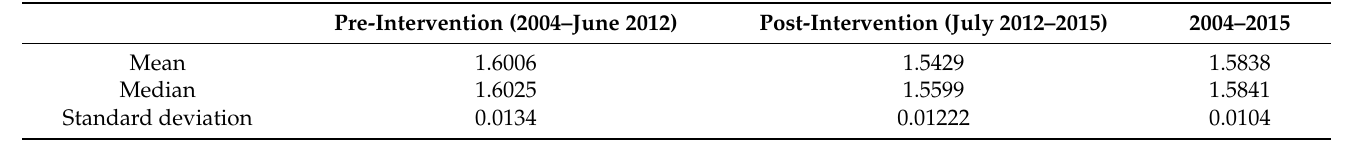
Table 3. Descriptive statistics of the per-capita prescriptions dispensed in Spain during the period